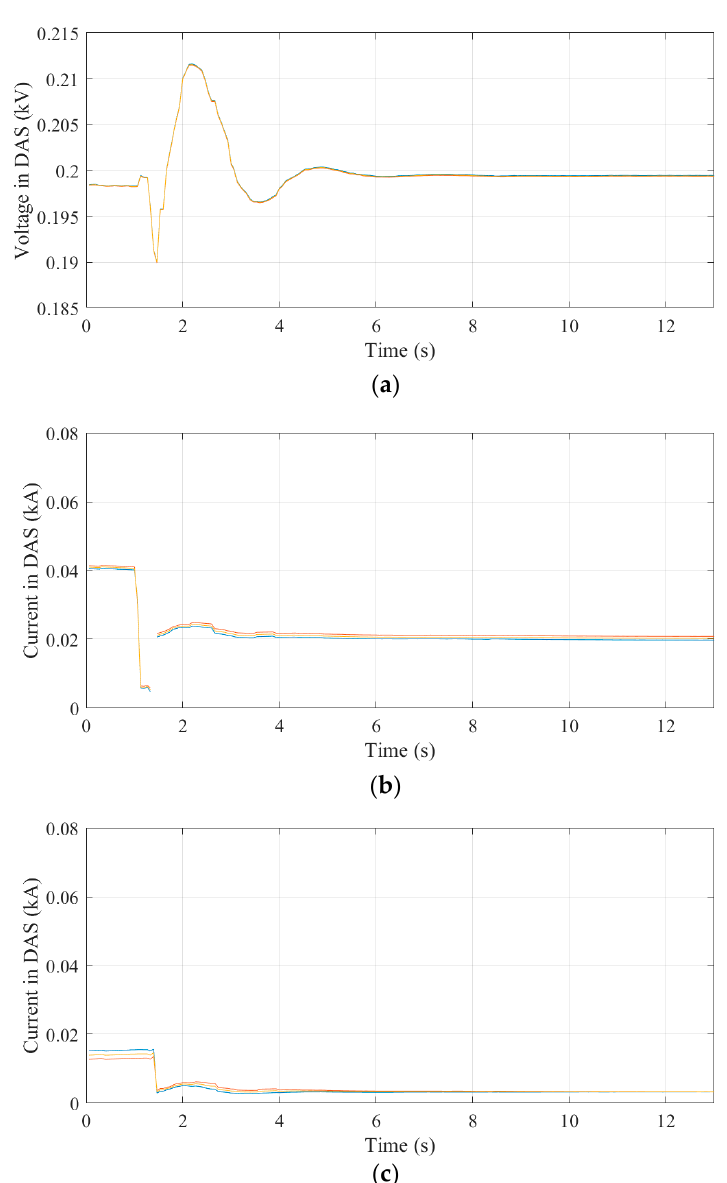
Figure A2. Test results when functions 1 and 2 are activated (load reduction from 19 kW to 7 kW): ( a ) line-to-line bus voltages; ( b ) line currents of DG set; ( c ) line currents of BESS.